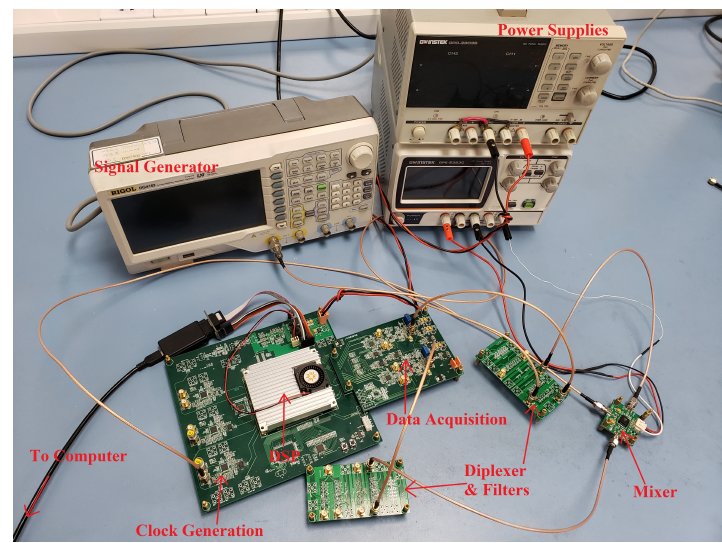
Figure 12. Prototype system under test.